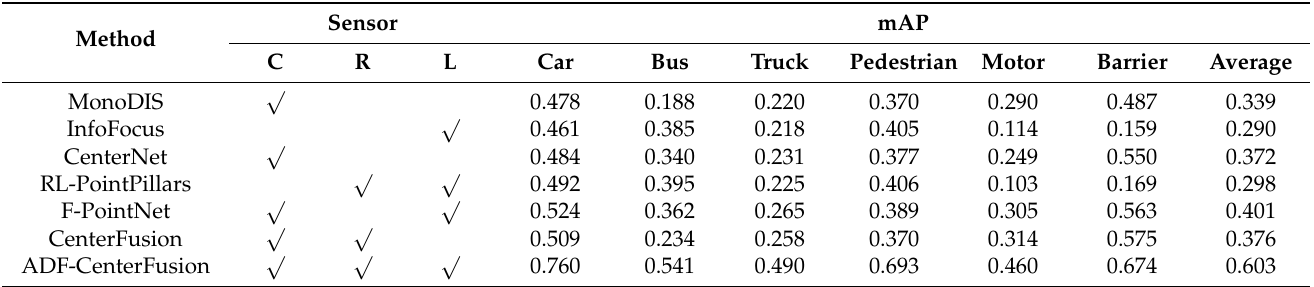
Table 3. Per-class performance comparison for 3D object detection on nuScenes